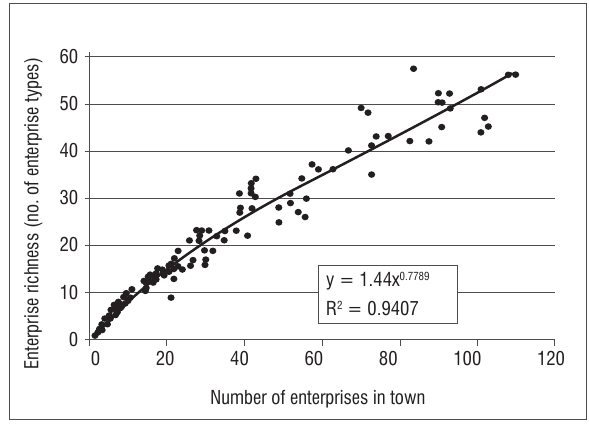
Figure 2: Enterprise richness as a function of the total enterprise numbers of 88 smaller (<115 enterprises per town) South African